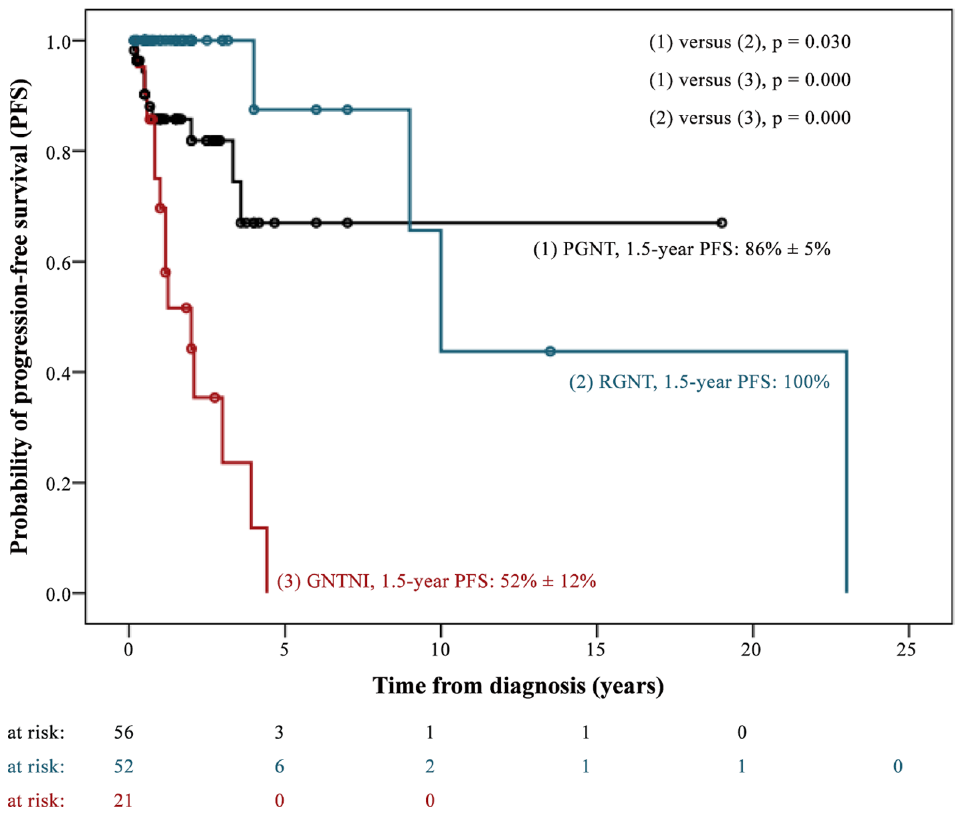
Figure 3. Kaplan-Meier Plot PFS.